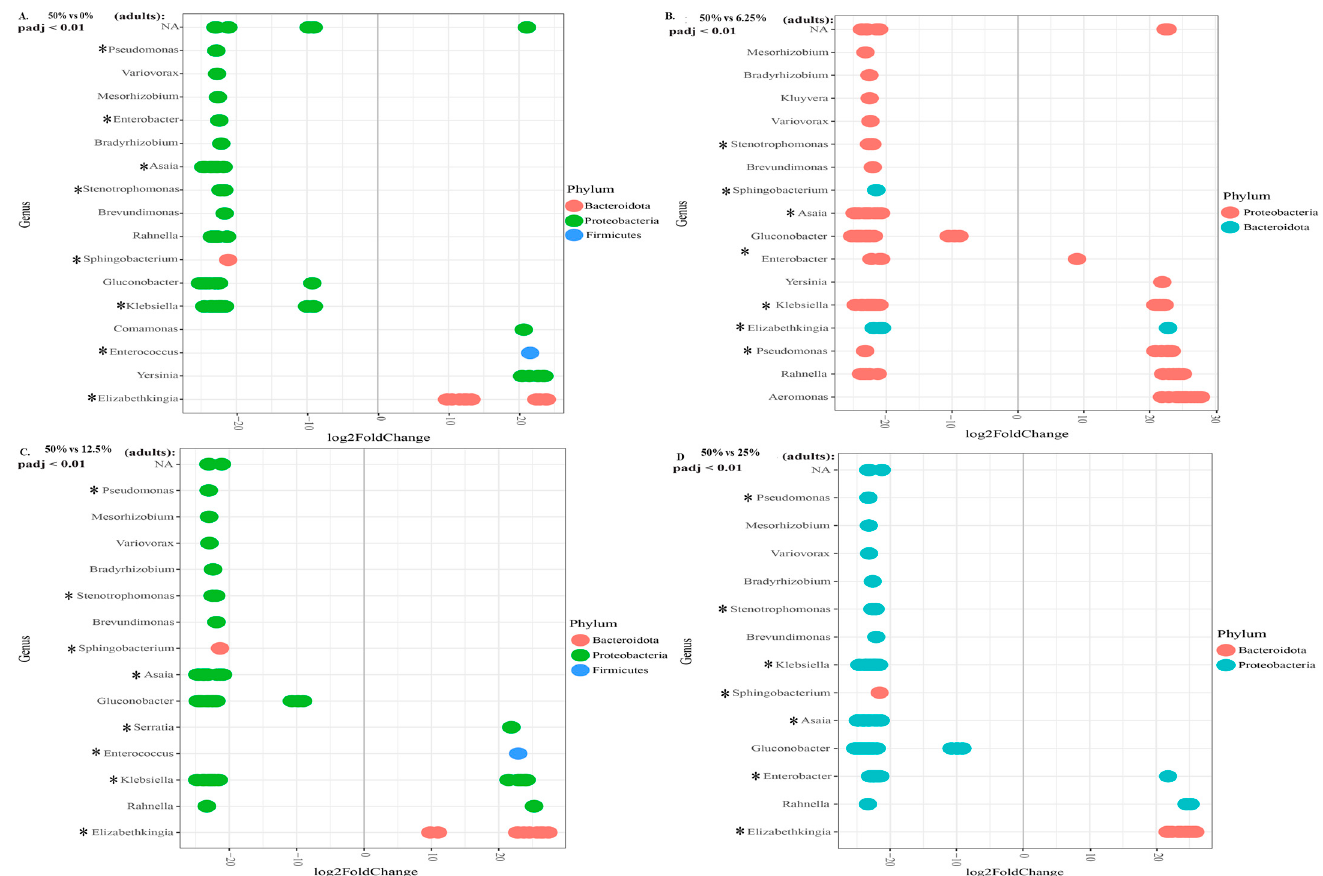
Figure 7. Differential abundance of microbiota in treatments compared to a 50% seawater treatment. Genera to the left of 0 are abundant in the 50% treatment, while genera to the right of 0 are abundant in the comparative concentration. ( A ) Adult 50% compared to 0% treatment. ( B ) Adult 50% compared to 6.25% treatment. ( C ) Adult 50% compared to 12.5% treatment. ( D ) Adult 50% compared to 25% treatment. Genera with asterisks have been associated with protection against Plasmodium .